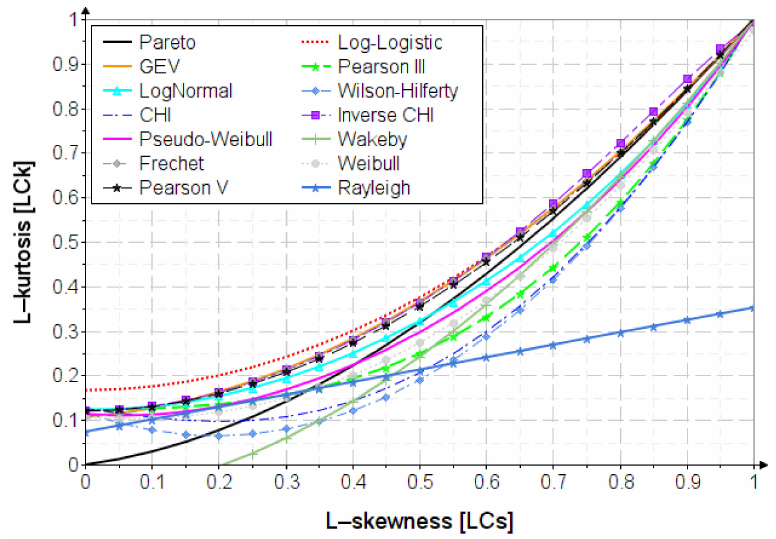
Figure A1. The variation diagram of LC s − LC k .